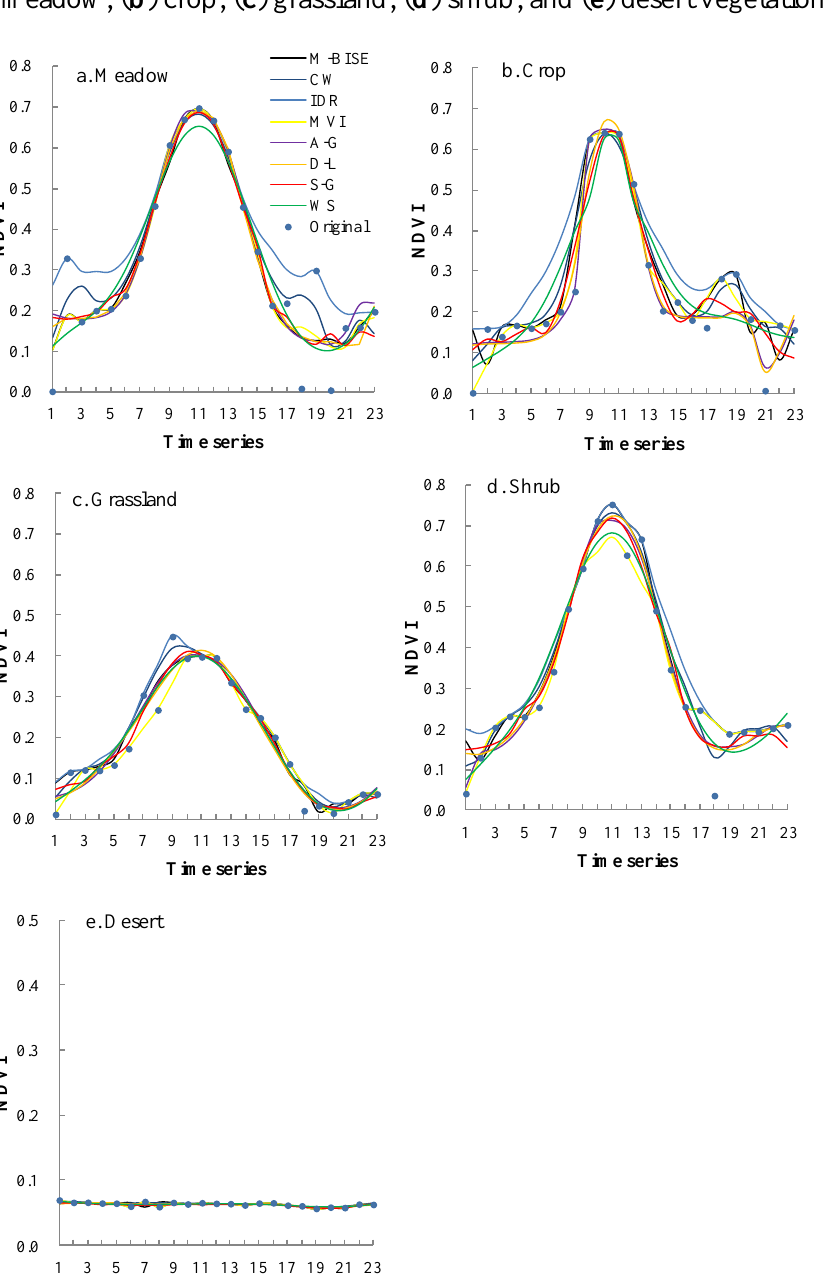
Figure 5. Eight techniques fitted to MODIS NDVI time-series data acquired from homogeneous pixels of ( a ) meadow; ( b ) crop; ( c ) grassland; ( d ) shrub; and ( e ) desert